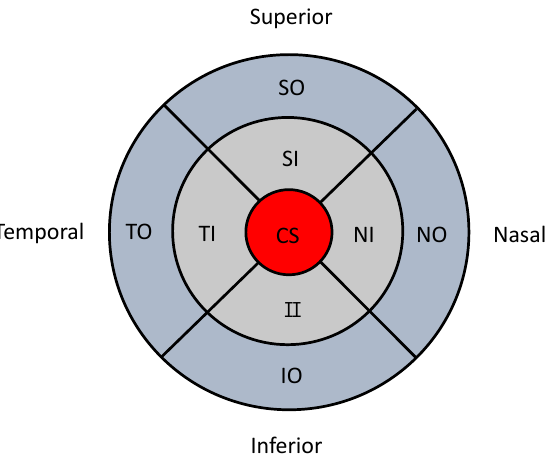
Figure 1. Early Treatment of Diabetic Retinopathy Study (ETDRS) grid centred on the fovea with the radii of the central circle being 500 µ m, inner circle 1500 µ m and outer circle 3000 µ